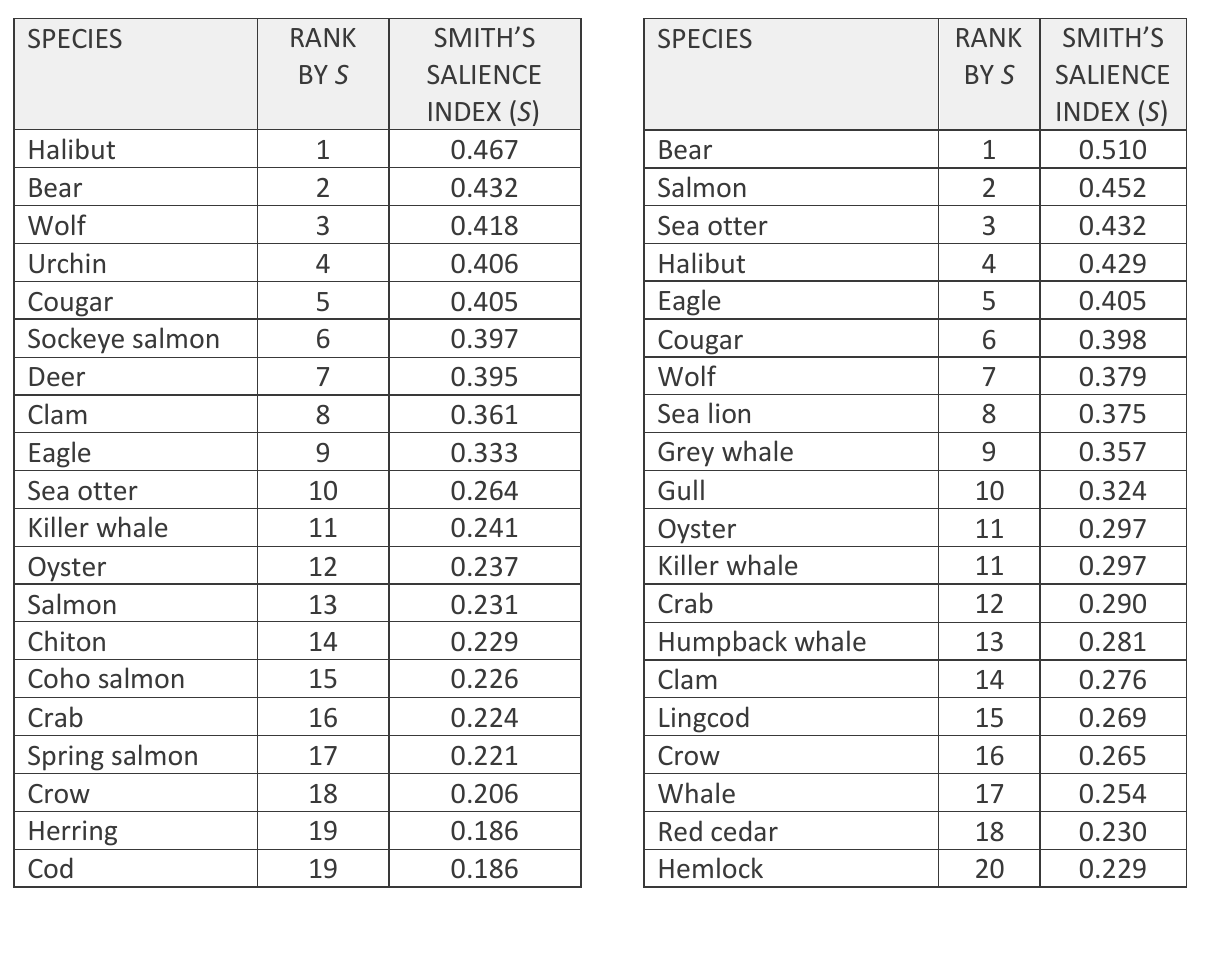
Table (cid:4)(cid:1008) .5